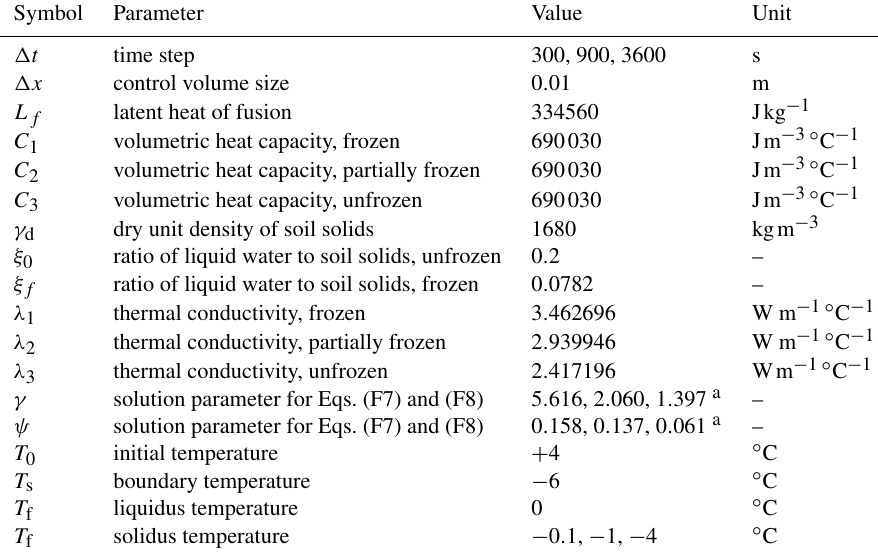
Table F1. Input parameters for the comparison between the Lunardini analytical solution and the numerical solution with the NCZ algorithm. Symbol